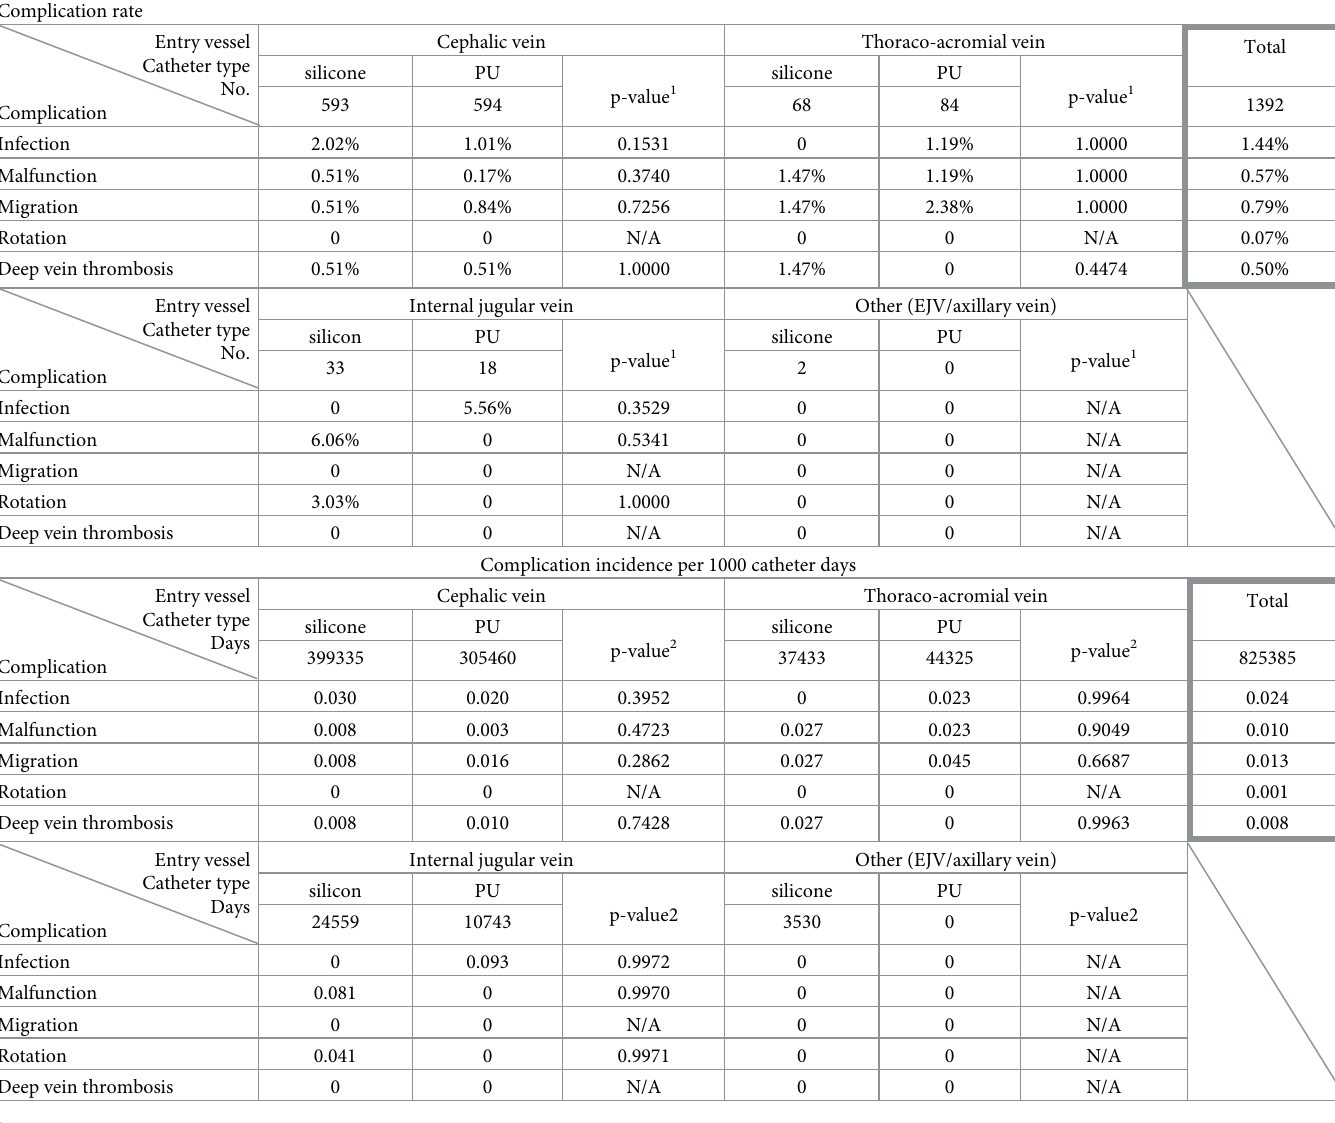
Table 2. Comparison of complication rates and incidences between polyurethane and silicone